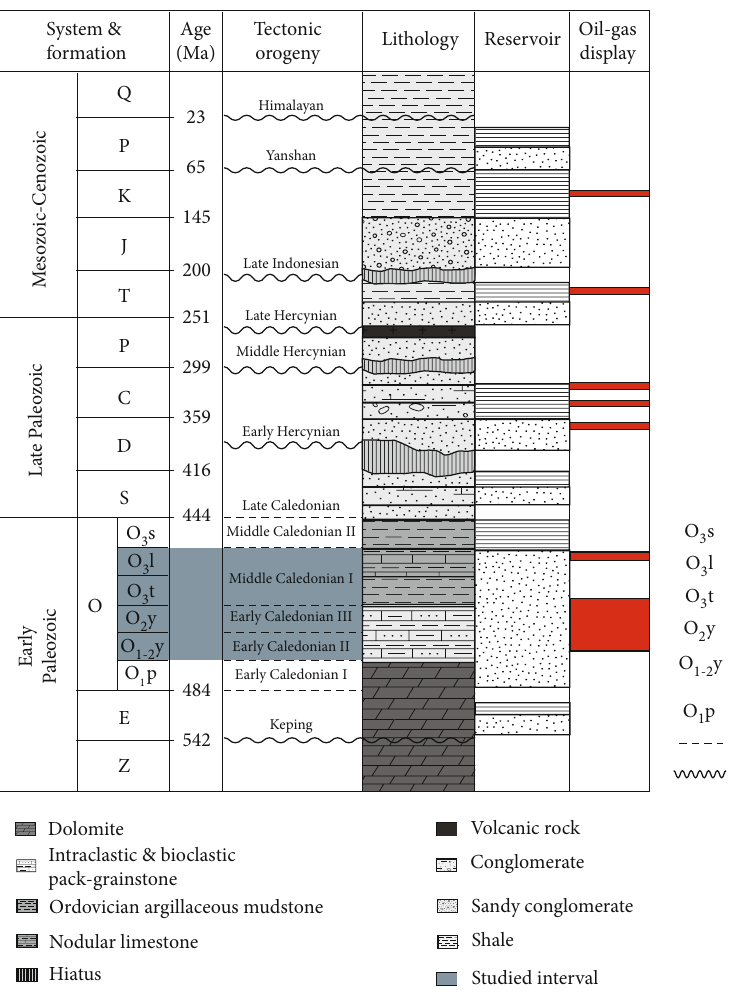
Studied interval Figure 2: Stratigraphy and lithology of Paleozoic-Cenozoic sediments in the Tarim Basin, showing main unconformities and tectonic orogenies (modi fi ed from Chang et al. [57] and Zhao et al.